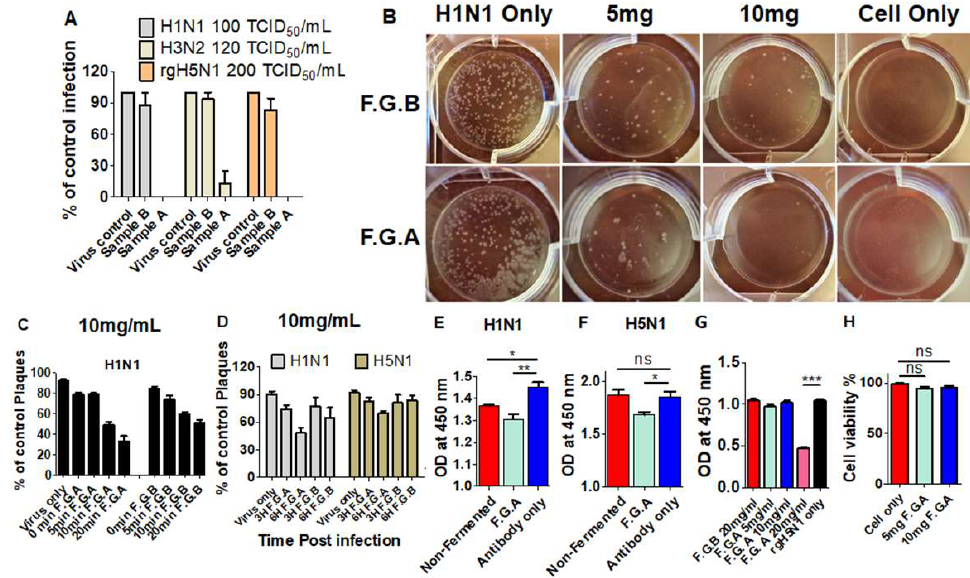
Figure 6. Fermented ginseng extract sample A had antiviral activity against influenza virus in vitro. ( A ) Microneutralization assay. Different strains of viruses (100 TCID 50 H1N1, 120 TCID 50 H3N2, and 200 TCID 50 H5N1) were incubated with 10 mg/mL of F.G.A or F.G.B for 1 hour at 37 °C and added to